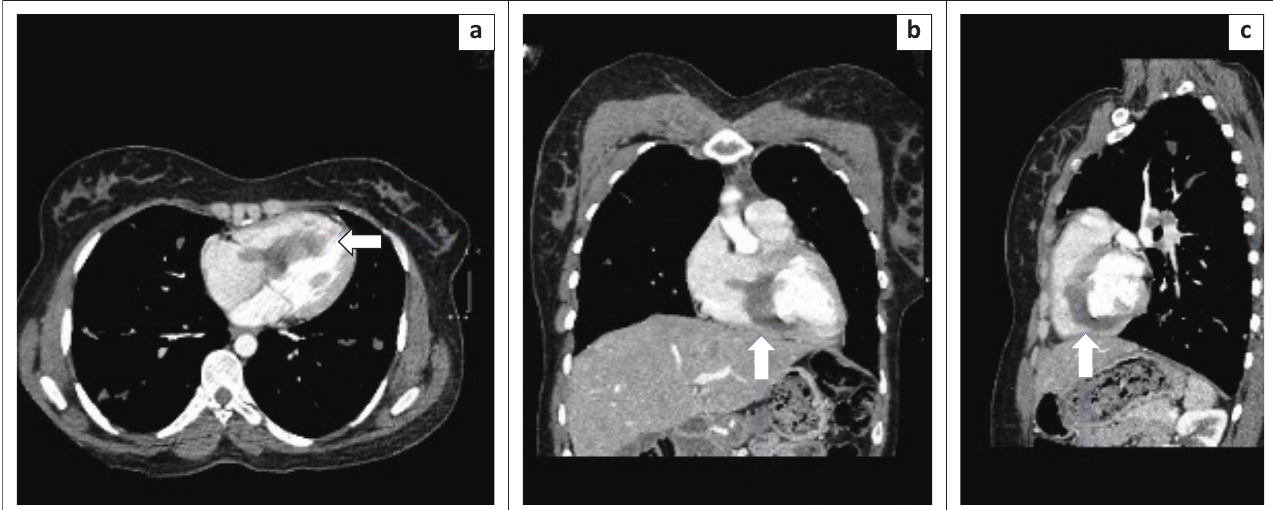
FIGURE 1: Computed tomography of the chest: (a) axial; (b) coronal; (c) sagittal demonstrating a well-defined interventricular hypodensity protruding into the right ventricle and right atrium (arrows).